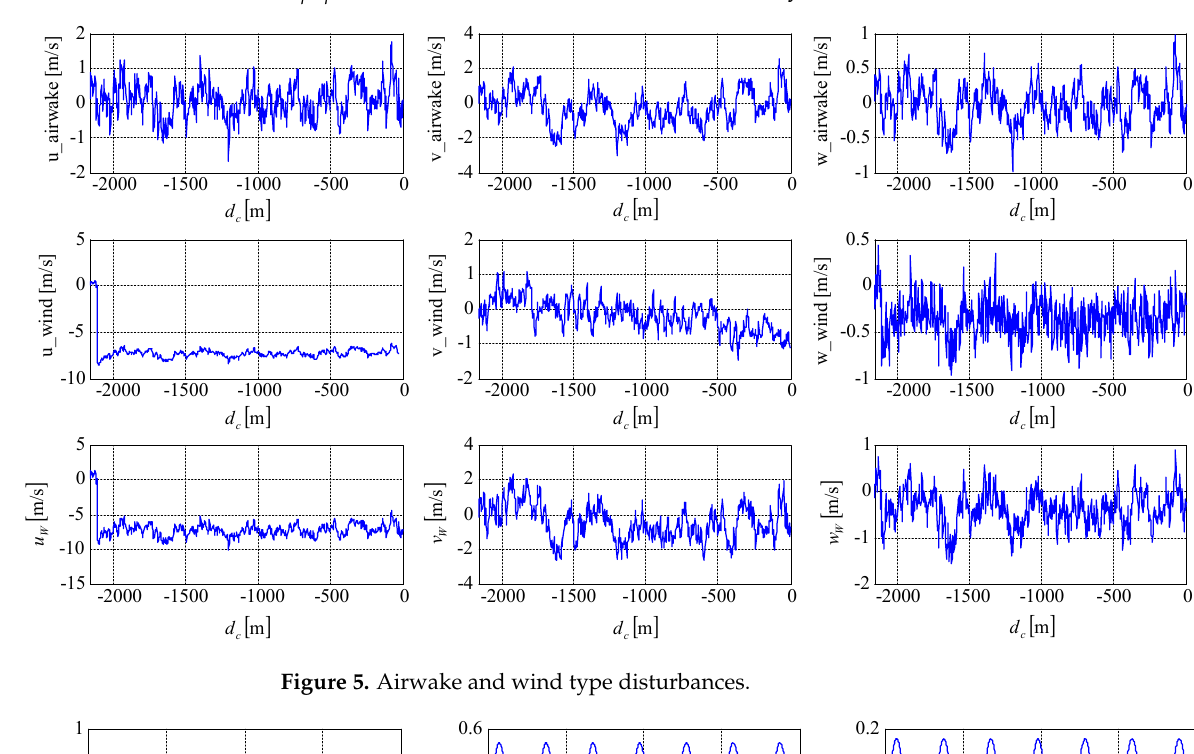
Figure 5. Airwake and wind type disturbances.